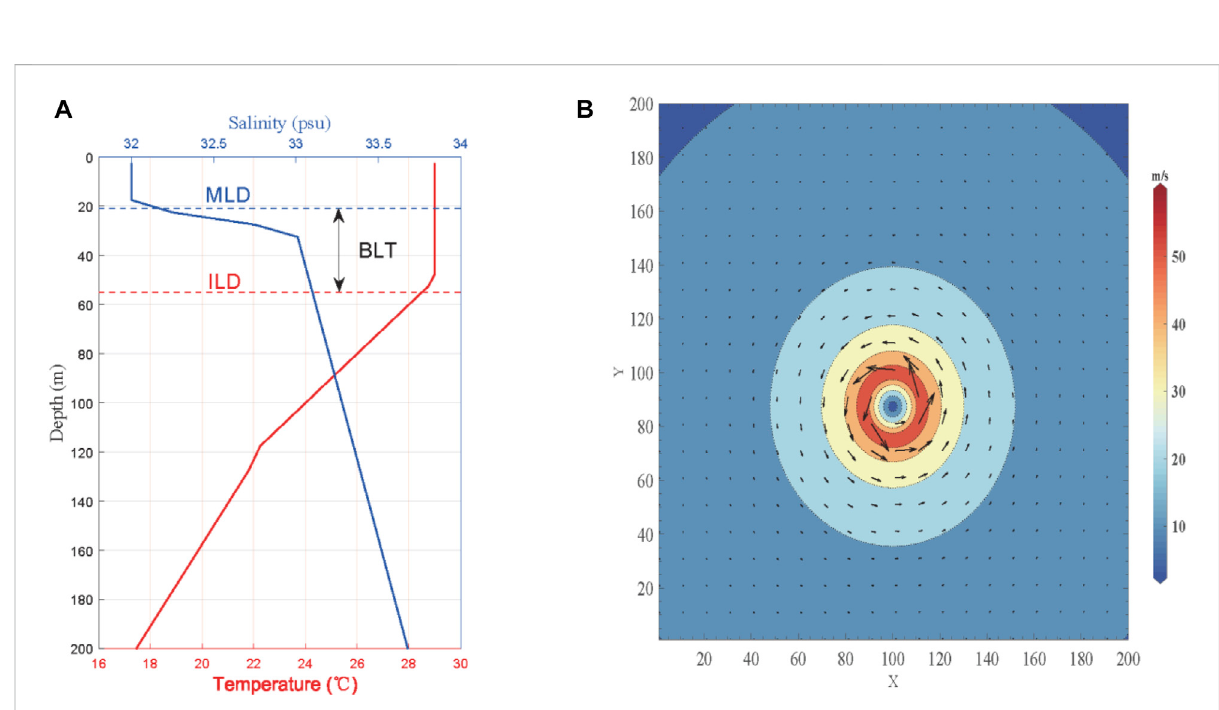
FIGURE 10 (A) Temperature( ° C)andsalinity(psu)pro fi lesusedin3DPWPsimulations.TheblueandreddashedlinesrepresentMLDandILDrespectively. (B) vector wind fi eld used in the simulation, with color shading for wind